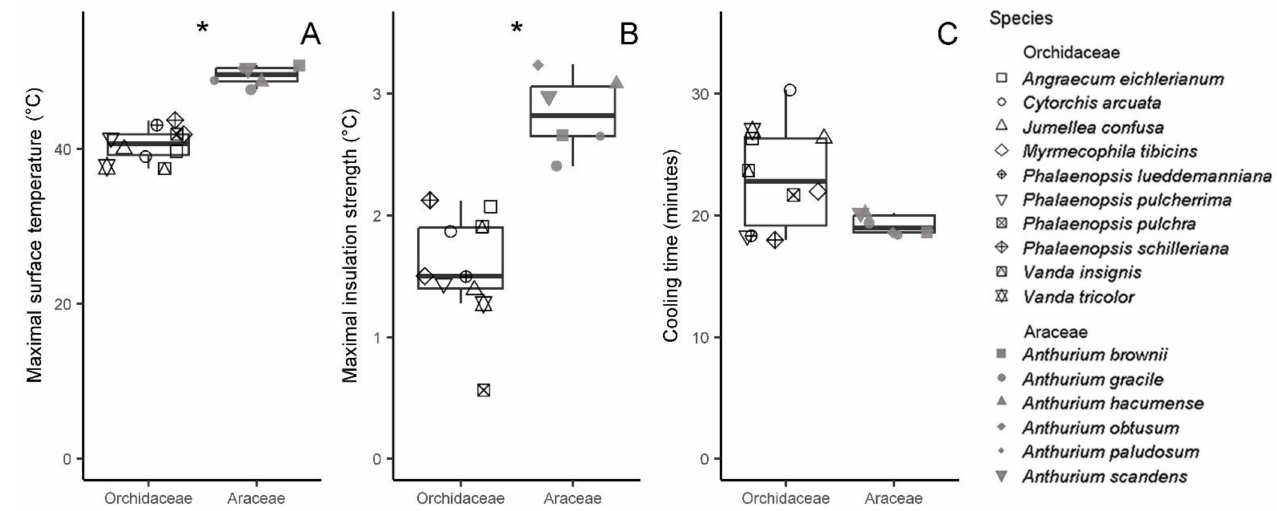
Figure 1. Comparison of thermal insulation traits: maximal surface temperature (T max , ( A )), maximal insulation strength ( ∆ T max , ( B )) and cooling time (t cool , ( C )) between 16 species of Orchidaceae and Araceae. Significant differences are indicated with an asterisk ( p < 0.05).